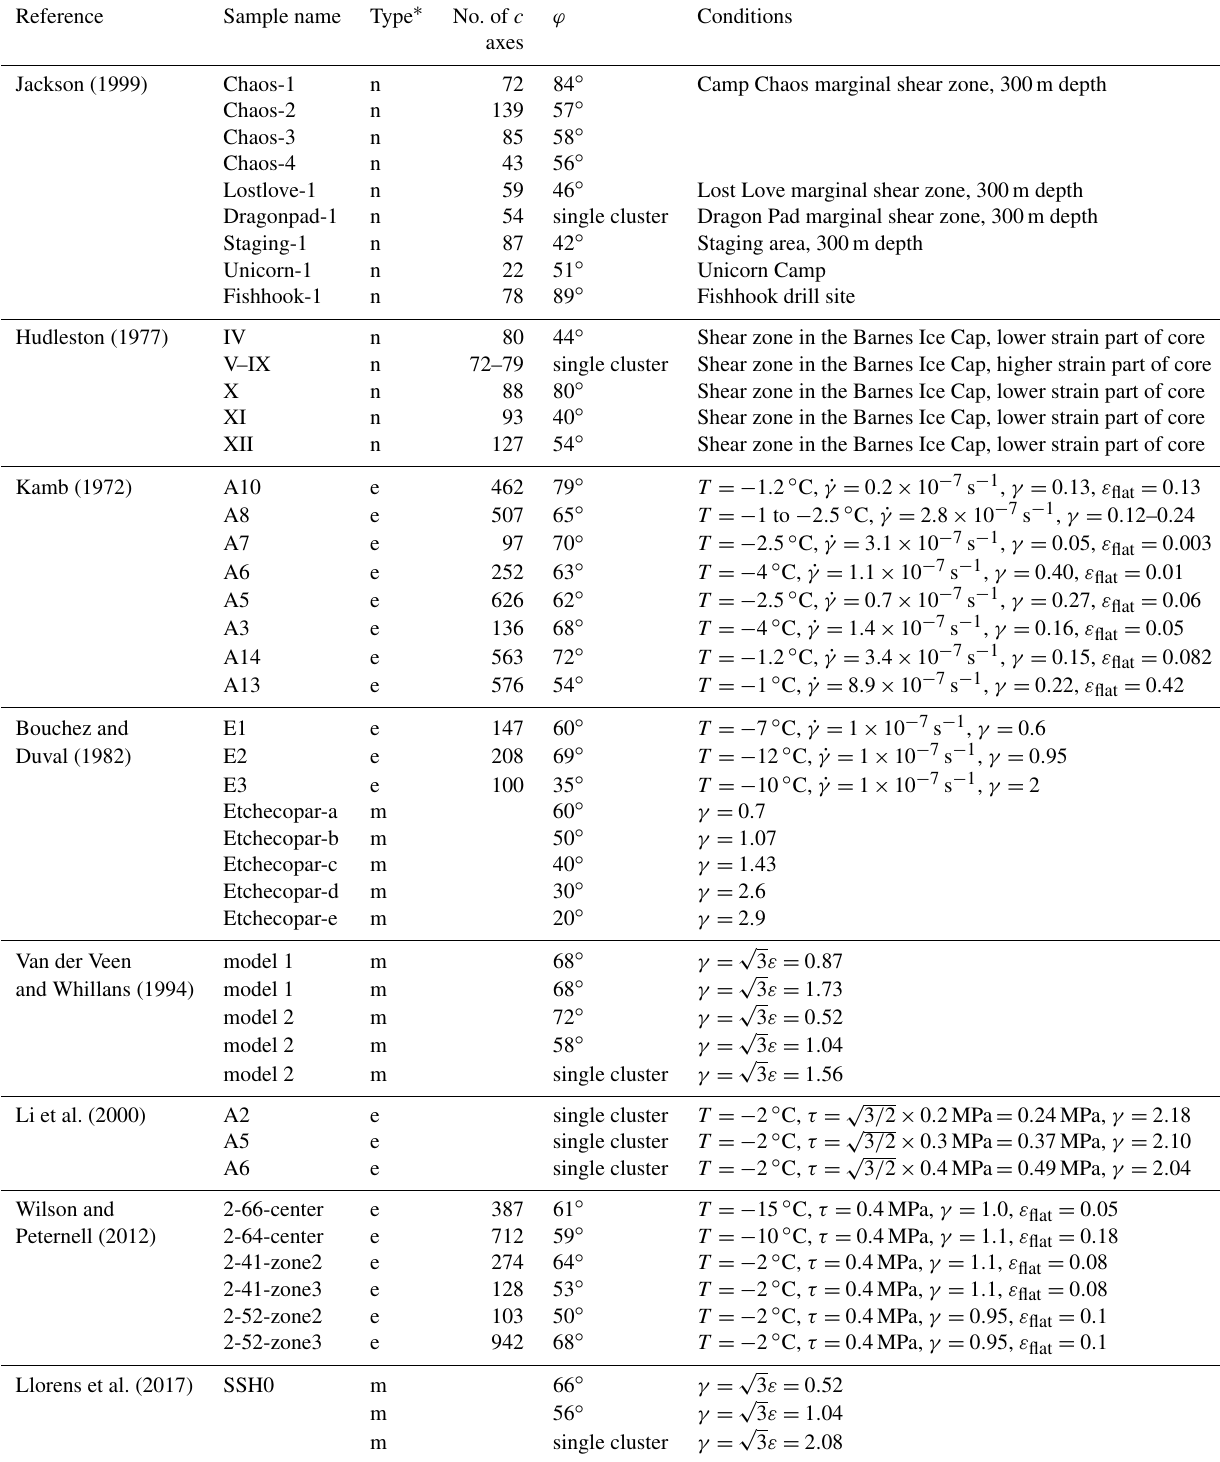
Table 3. The CPOs of sheared ice reported in the literature.